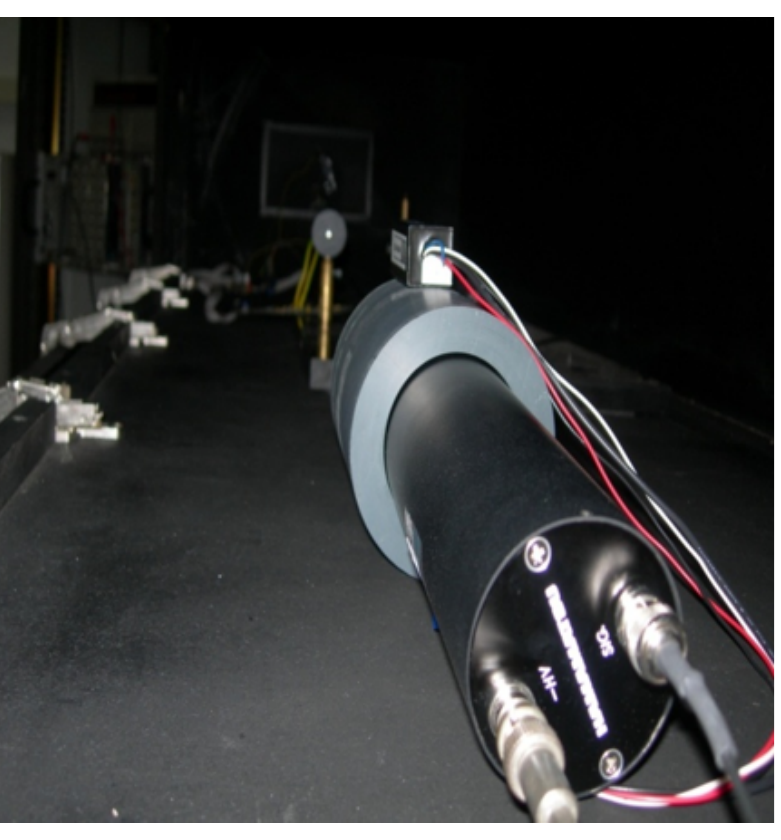
Figure 12. Photo-electron setup inside the dark box. In the foreground, the photo-electron PMT with the trigger PMT mounted on top it is seen. In the background, the LED pulser can be observed.